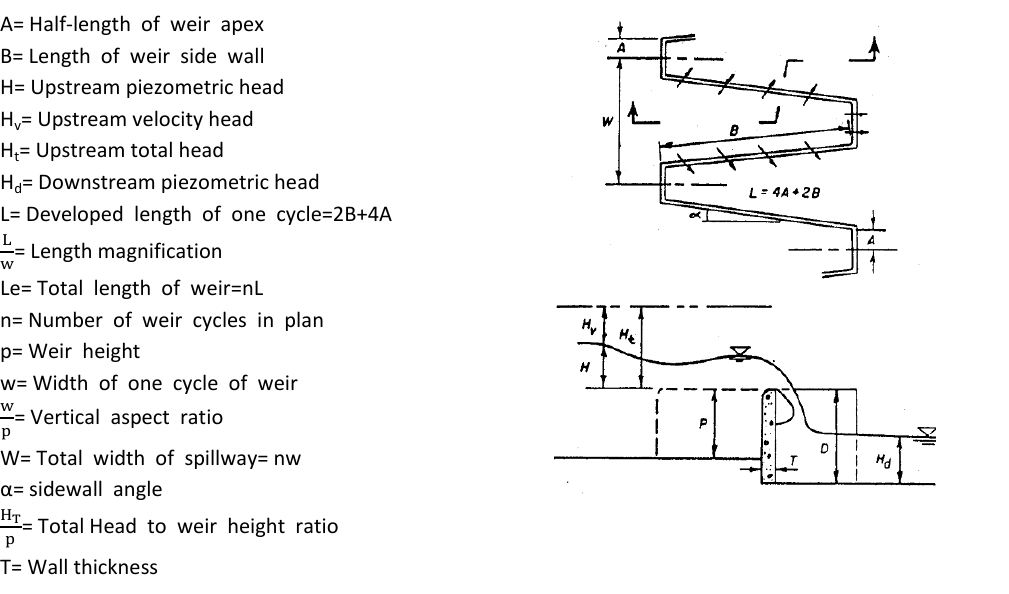
Figure 1. An overview of linear labyrinth spillways with details (Copeland and Fletcher